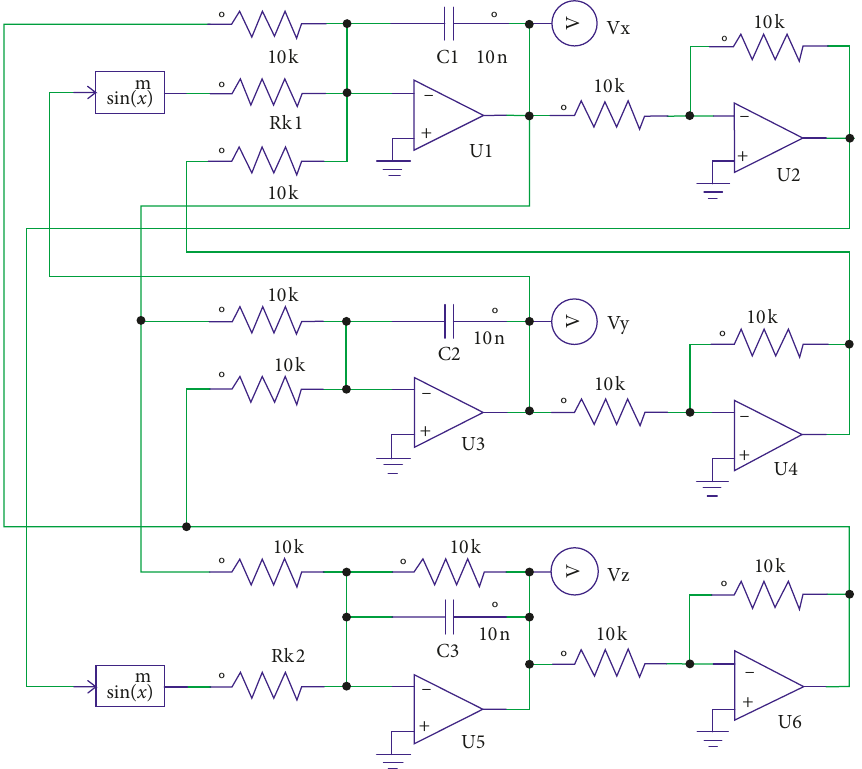
Figure 9: Screen shot of PSIM simulation-oriented circuit model for implementation of the presented sine system.